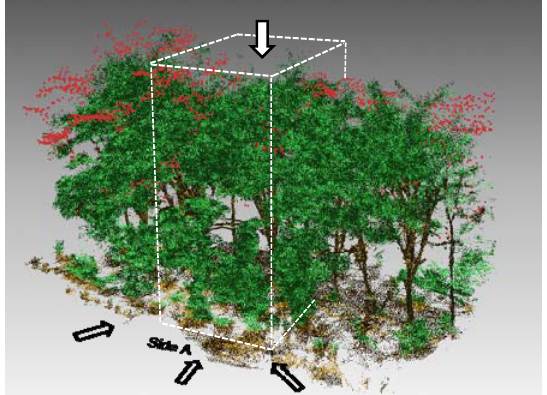
Figure 3: A 3-D image of the Japanese zelkova canopy at the study site, obtained by registration of the images measured from above with the airborne lidar and from the six ground positions with portable ground-based lidar (the data obtained from the airborne lidar are colored red: Hosoi et al., 2010) .